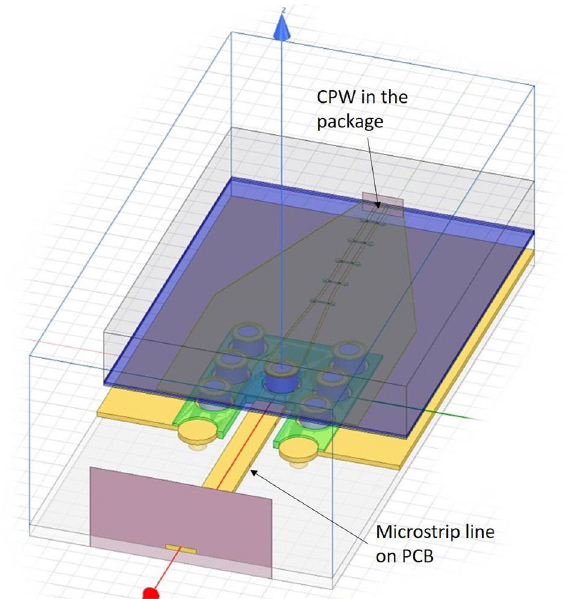
Fig. 9 Subset of the 3D package model including coplanar waveguide (CPW) port, transition from package to PCB, and microstrip on the PCB